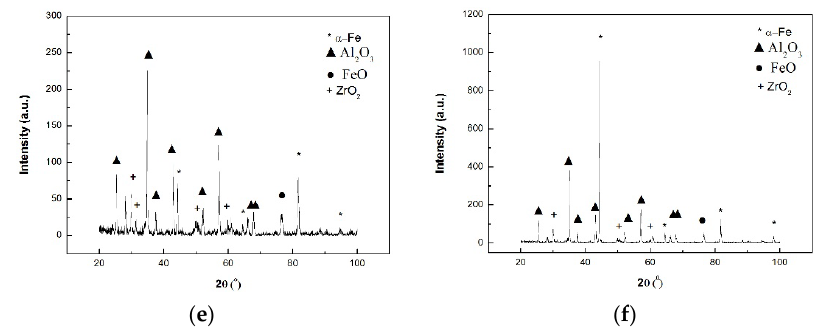
Figure 3. XRD patterns of oxide layers treated at different temperatures for 3 h: ( a ) 1220 ◦ C, ( b ) 1260 ◦ C,